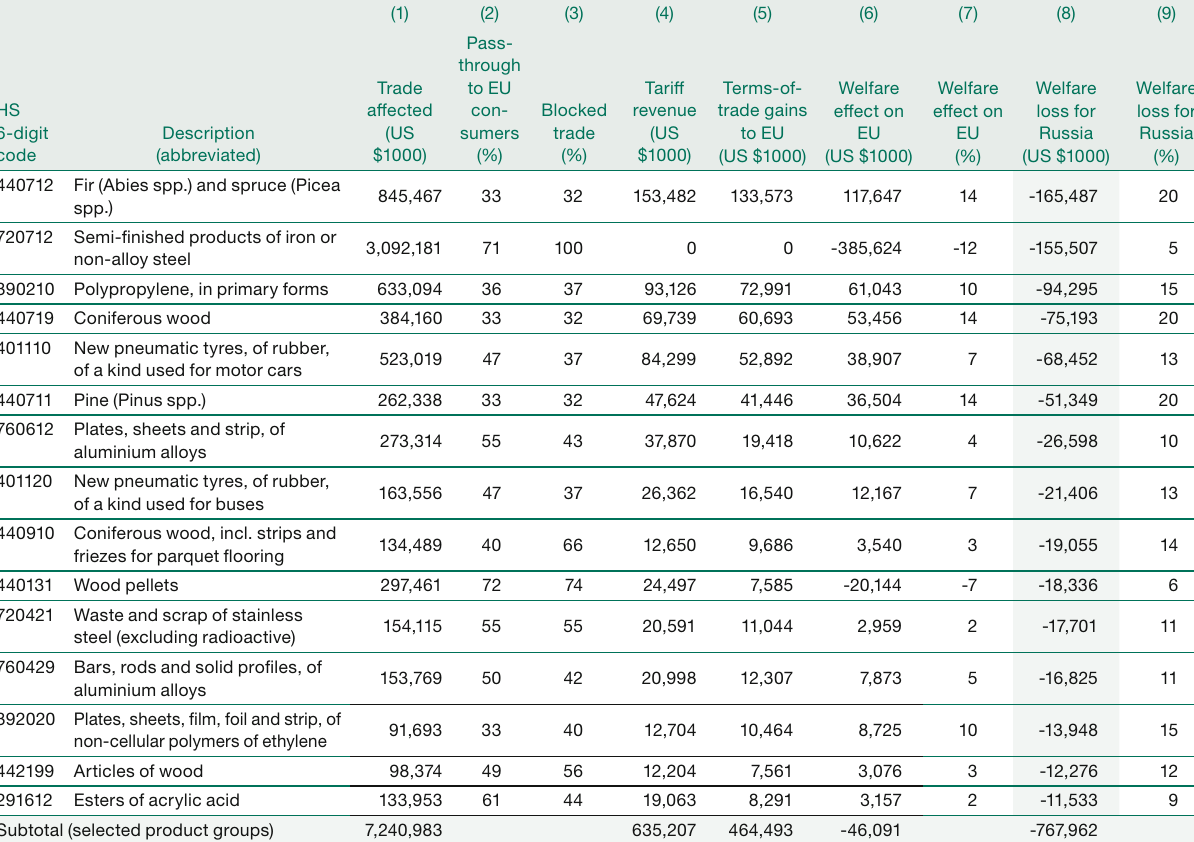
Sectors with high absolute welfare losses to